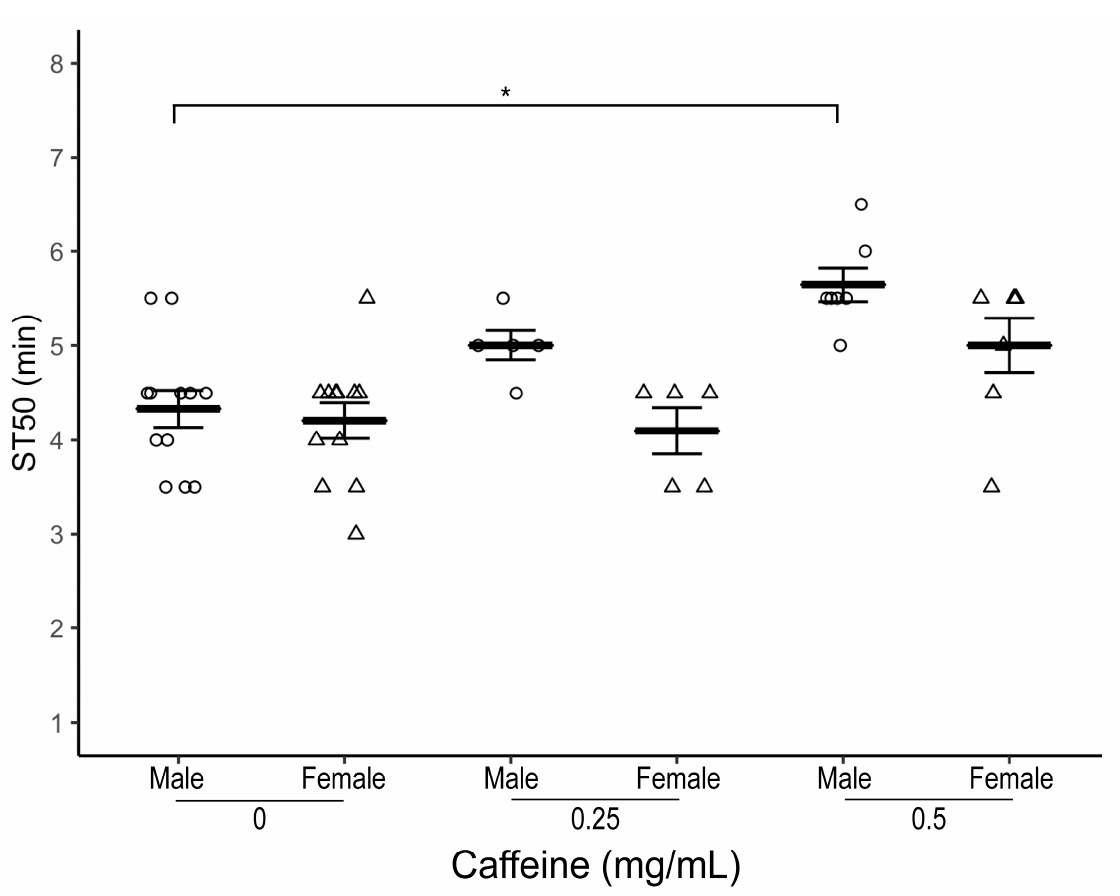
Figure 2. Effect of caffeine supplementation on ethanol-induced sedation in wildtype ( OR-R ) flies. Comparison of ST50 when exposed to 100% ethanol of 1–3 day old male (circles) and female (triangles) OR-R flies raised for three days at different dosages (0.25 and 0.5 mg/mL) of caffeine-supplemented food. Both male and female flies raised on 0.5 mg/mL caffeine-supplemented food for three days have the most elevated ST50 than control flies ( p = 0.04 (males), p = 0.06 (females)). Horizontal bars represent the mean ST50 ± standard error of 5–12 biological replicates. For each ST50 8–10 male and female flies were used. * p < 0.05; ANOVA, post hoc Tukey HSD.